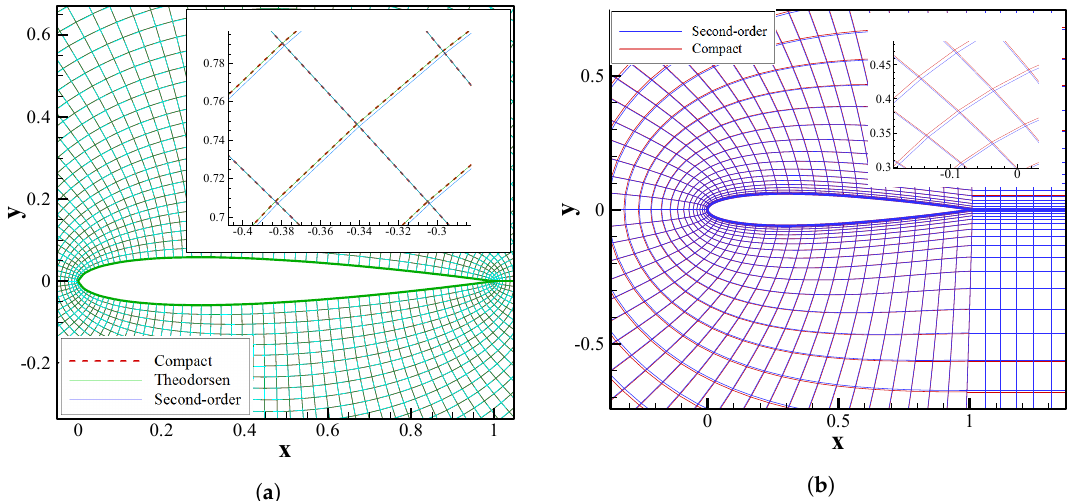
Figure 8. ( a ) O-type and ( b ) C-type grids generated around a NACA 0012 airfoil using different techniques, i.e., the fourth-order compact scheme, the Theodorsen’s scheme, and the standard second-order scheme.